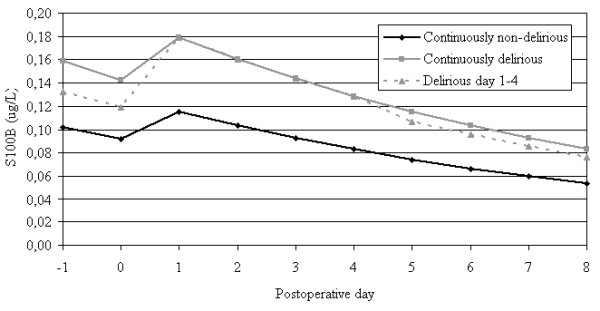
Three representative patients with an intertrochanteric fracture to show the changes of S100B during admission calculated with values of the mixed model analysis of all samples. The final model included delirious state (p < 0.001), day of blood withdrawal (p < 0.001), pre- or postoperative status (p = 0.001) and type of fracture (p = 0.036). Postoperative day 0 is day of surgery.